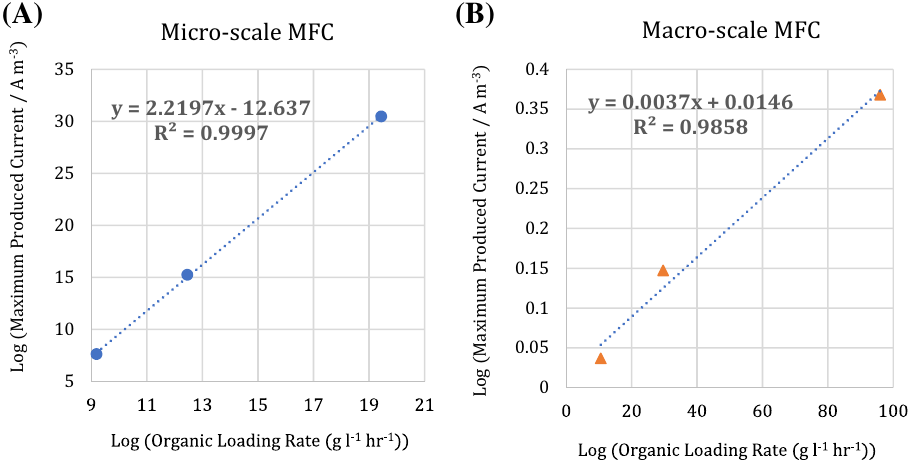
Figure 7. The maximum produced current density versus organic loading rate for ( A ) micro-scale and ( B ) macro-scale MFCs.